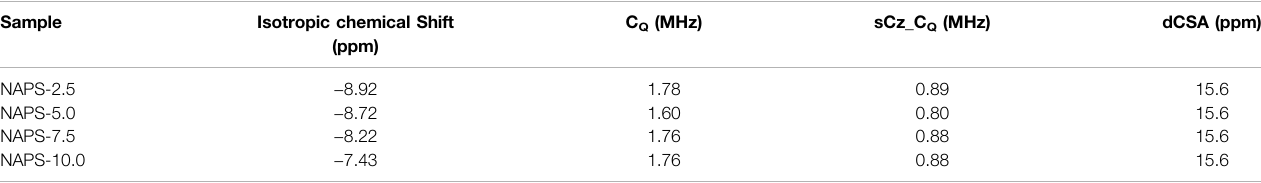
TABLE 5 | 23 Na MAS-NMR deconvolution parameters. sCZ_CQ represent the distribution of Quadrupolar coupling constant CQ. dCSA represents the distribution of isotropic chemical shift.